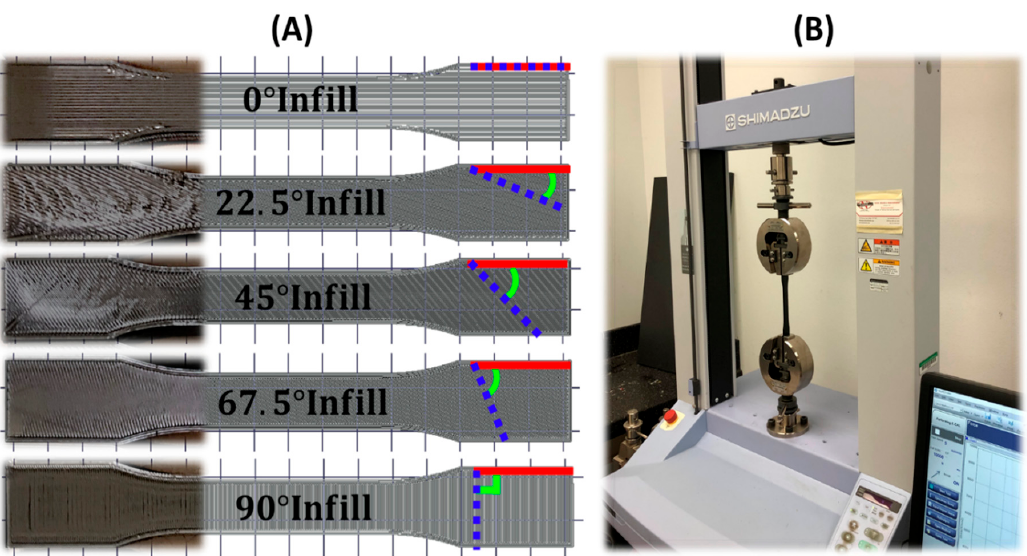
Figure 2. ( A ) Designed and printed ABS tensile samples with 0 ◦ , 22.5 ◦ , 45 ◦ , 67.5 ◦ , and 90 ◦ infilled angles illustrated by photographs and slicing path together. The tensile force on all the samples is along the horizontal direction. ( B ) Photograph of the involved 10 KN tensile test machine with a printed tensile sample attached.